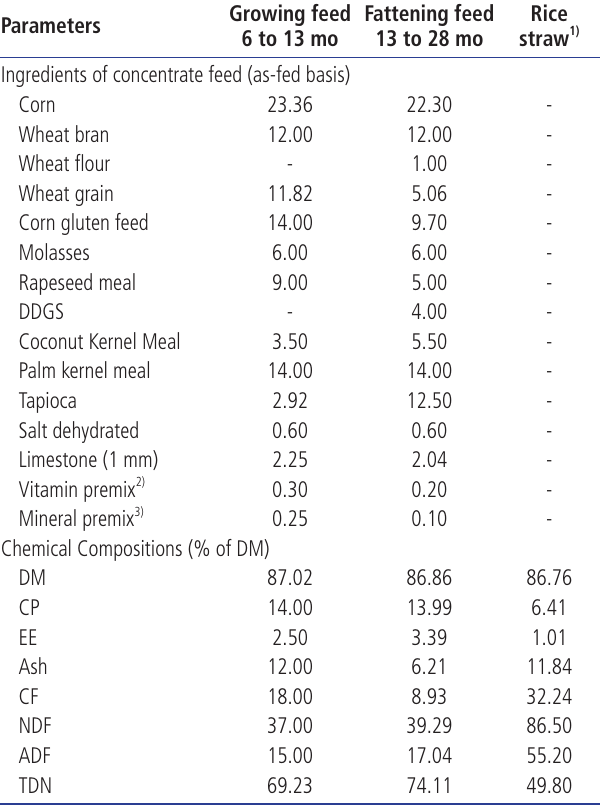
Table 1. Ingredients and chemical compositions of feeds used for in vivo experiment